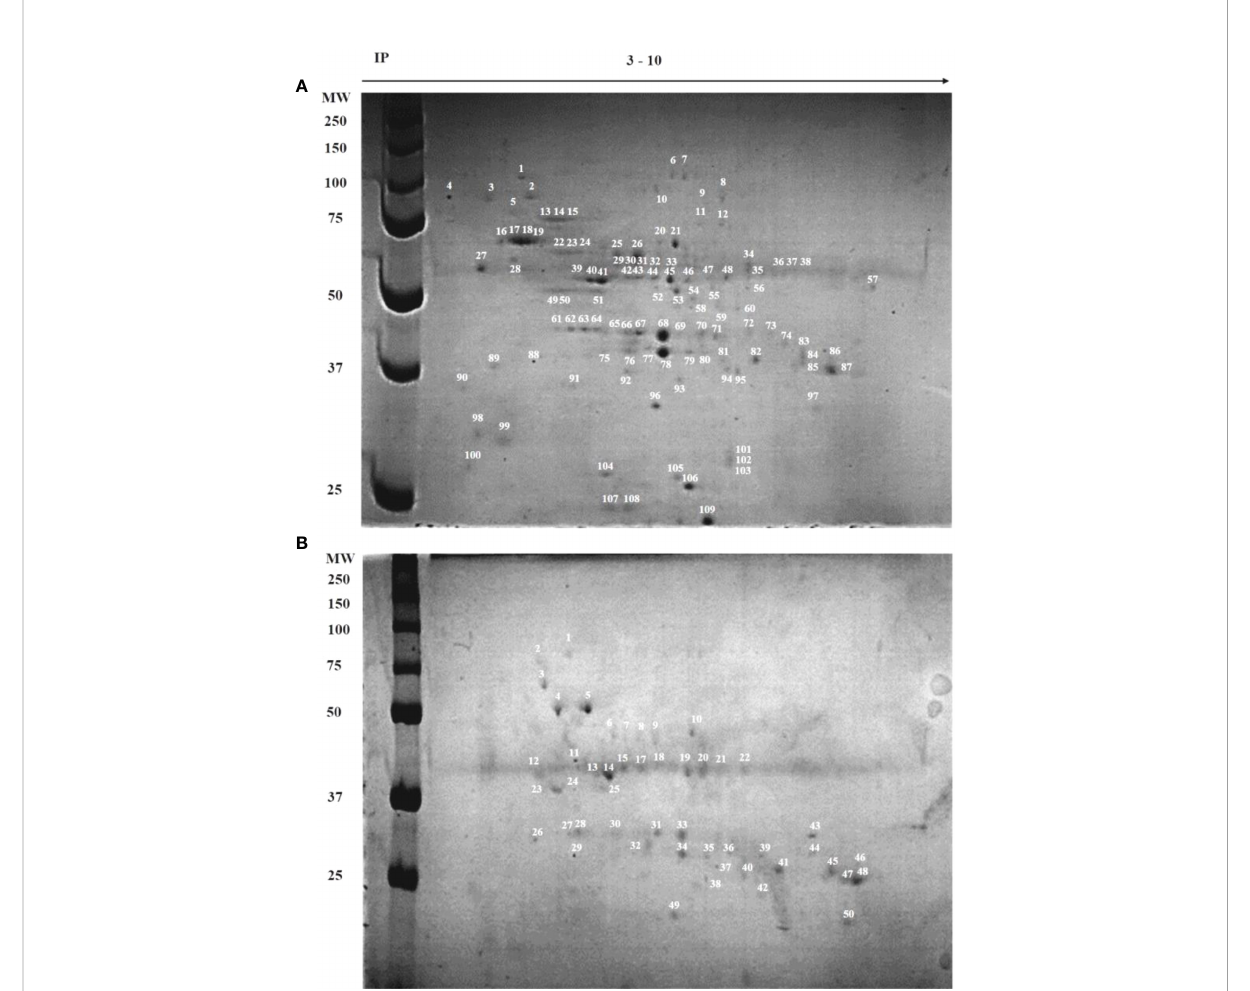
FIGURE 3 Two-dimensional electrophoresis (IP: 3 – 10) of wild-type and transgenic C. papaya callus cell lines. (A) CF-WT line; (B) CF-23 line. The proteins labeled by numbers were identi fi ed (supporting information, Supplementary Table 1). Left lanes show molecular weight markers (MW), isoelectric point